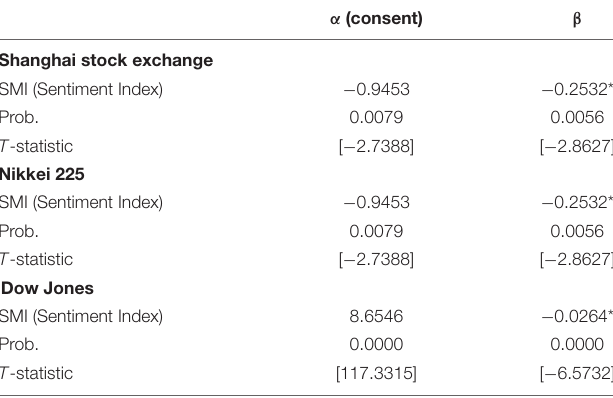
TABLE 10 | The relationship between stock exchange and Sentiment Index during